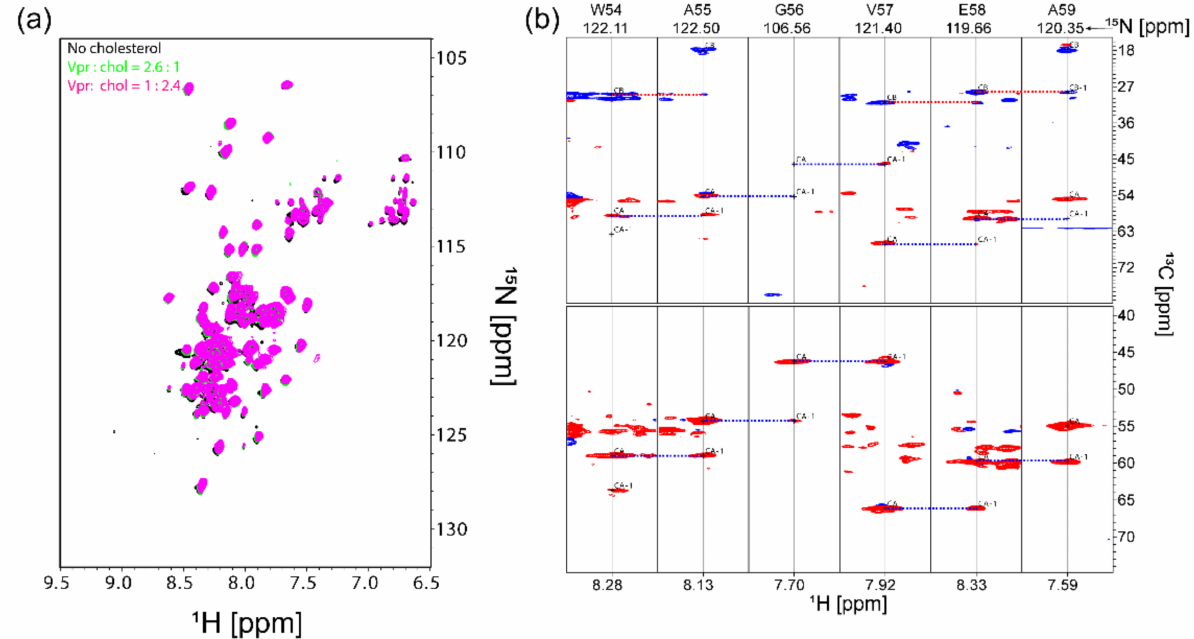
Figure 4. Solution NMR characterizations of [U- 2 H, 13 C, 15 N]-Vpr in [ 2 H 25 , 98%] DPC micelles. ( a ) 2D TROSY-HSQC spectra of [U- 2 H, 13 C, 15 N]-Vpr solubilized in [ 2 H 25 , 98%] DPC detergent micelles with and without the addition of cholesterol. ( b ) The strips for residues 54–59 from a 3D TROSY-HNCACB (top) and 3D TROSY-HNCA experiments of [U- 2 H, 13 C, 15 N]- Vpr in [ 2 H 25 , 98%] DPC. Red and blue peaks arise from C α and C β nuclei, respectively. The blue and red dashed lines indicate the sequential connection between the